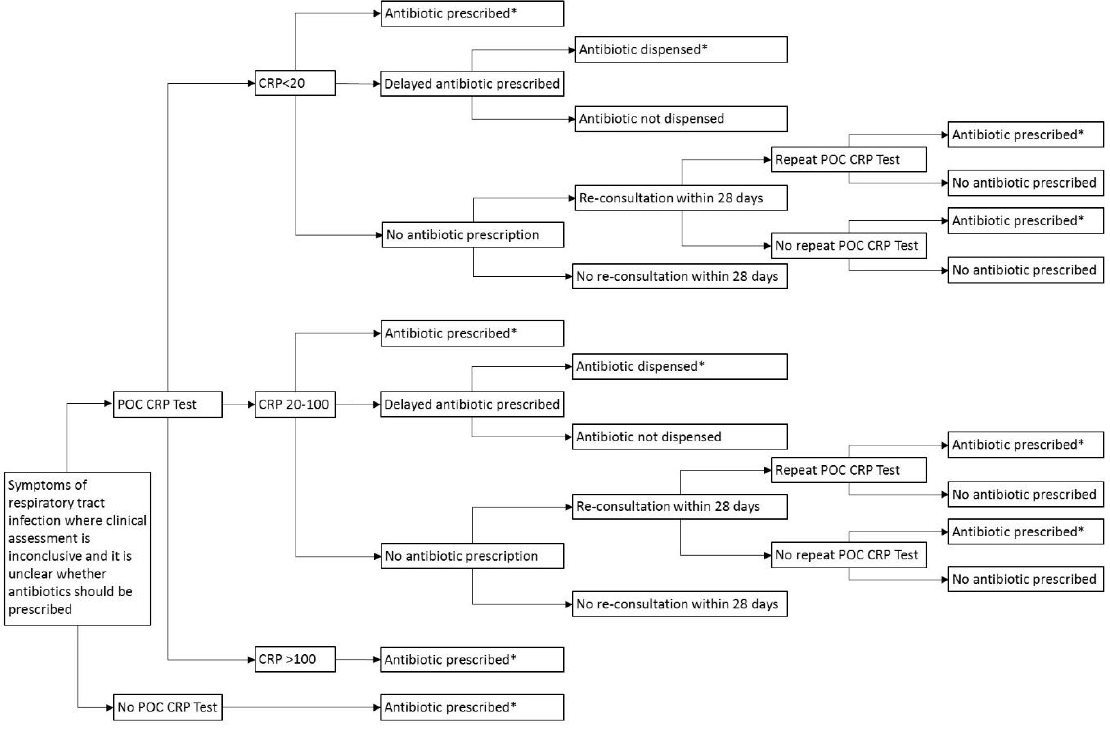
Figure 3. Decision tree for pragmatic use of POC CRP testing, reflective of practice. POC: Point-of-care; CRP: C-reactive protein; *Amoxicillin 500 mg three times daily for 7 days.